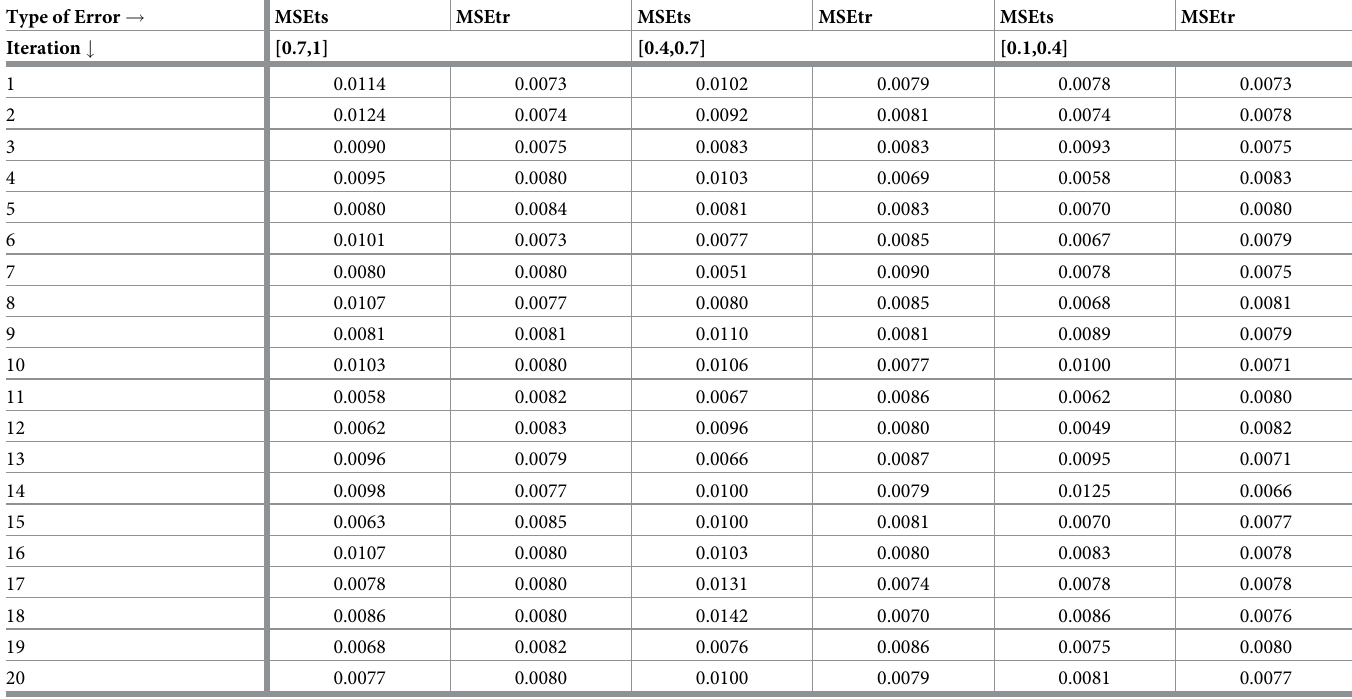
Table 1. The results of the sum of the squared error in 20 implementation of ANN-BTA network in three ranges of [0.1, 0.4], [0.4, 0.7], [0.7, 1].